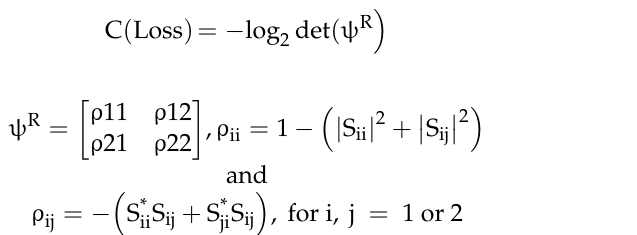
Figure 28. The DG outcomes of the MIMO antenna with FSS at port 1 ( a ) DG1, 2 ( b ) DG 1, 3 ( c ) DG 1, 4. The CCL indicates the upper constraint on data transmission rate and is studied to show its effect on the MIMO performance. The CCL should be <0.4 bits/s/Hz [32]. The CCL can be calculated using Equations (4) and (5)